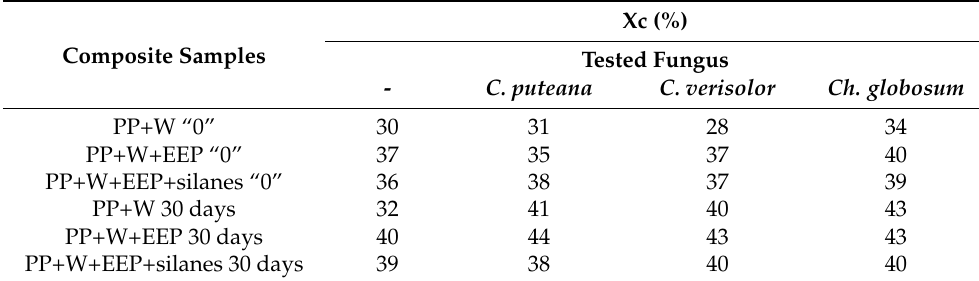
Table 2. The results of Xc-obtained composites